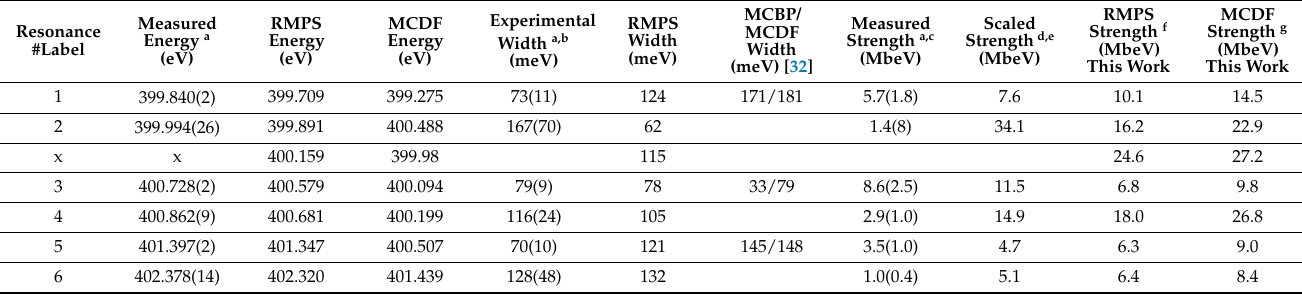
a The number in brackets is the numerical uncertainty on the last digit, i.e., 399.840(2) eV means 399.840 ± 0.002 eV obtained from a Voigt profile deconvolution of the experimental line shape (peak energy position and width). The overall energy uncertainly must also include the 60 meV energy calibration contribution (see text). b This is the Lorentzian width obtained from a Voigt profile deconvolution of the experimental line shape. c Obtained from a numerical integration of the measured line profile. d Obtained assuming 0.748 3 P + 0.194 1 D + 0.016 1 S + 0.041 5 S initial states contributions (see text). The numbers in this column are comparable with the theoretical RMPS and MCDF strengths. e Total strength of 83.2 Mb eV. f Total strength of 88.41 Mb eV. g Total strength of 118.6 Mb